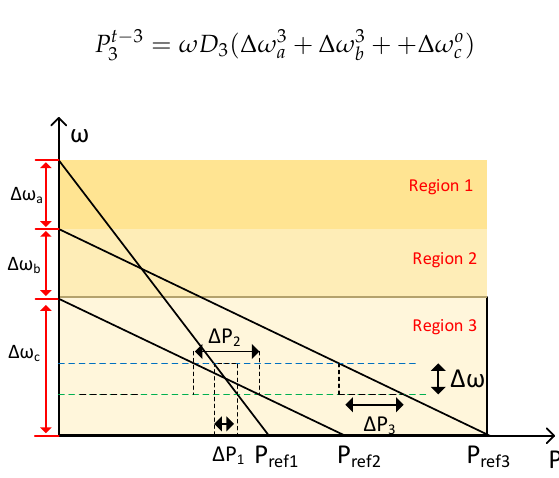
Figure 7. Regional Power Contribution Case III.